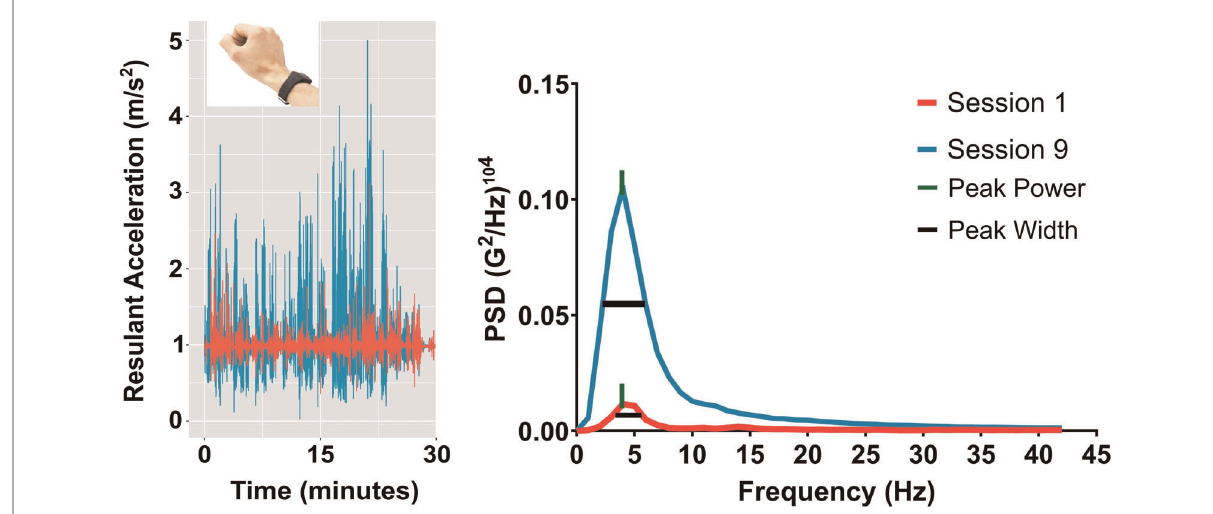
FIGURE 1 Summary of the acceleration analysis. On the left side are the raw acceleration pro fi les for Session 1 (magenta) and 9 (teal) along the resultant movement axis. On the right side is the resulting power spectral density function showing peak power and peak width for the same